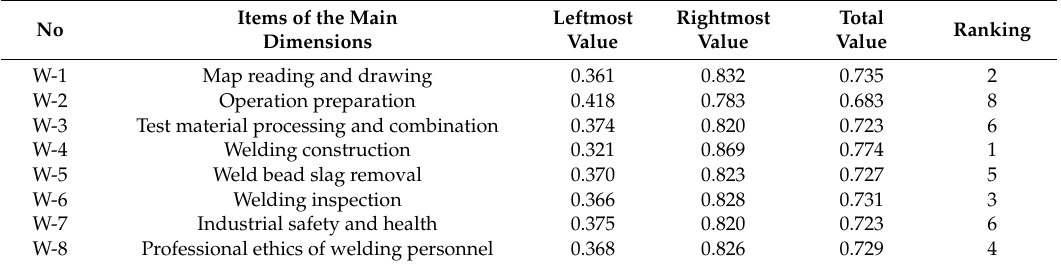
Table 3. Suitability Score Table of Ability Indices of the Main Dimensions of the Welding